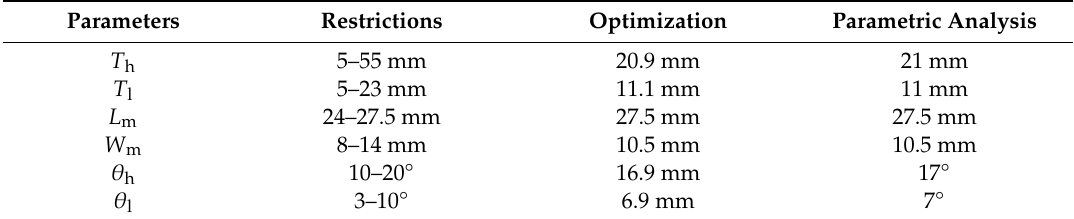
Figure 10. Procedure with the 3D FEM embedded in the optimization algorithm. Table 6. Optimal parameters of the